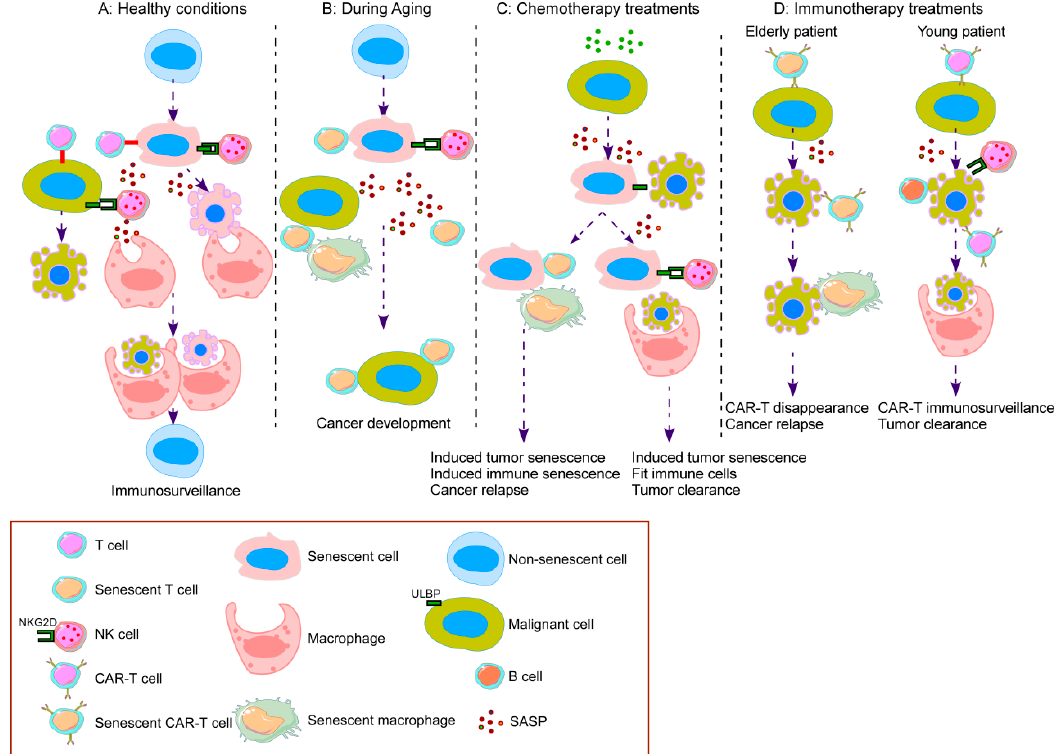
Figure 2. The complex and contrasting roles of senescence in the immune response to cancer. ( A ) Healthy conditions: proliferative cells react to stresses, such as DNA damage or oncogene activation, by inducing senescence to avoid malignancy. Immune cells, recruited by immunosupportive